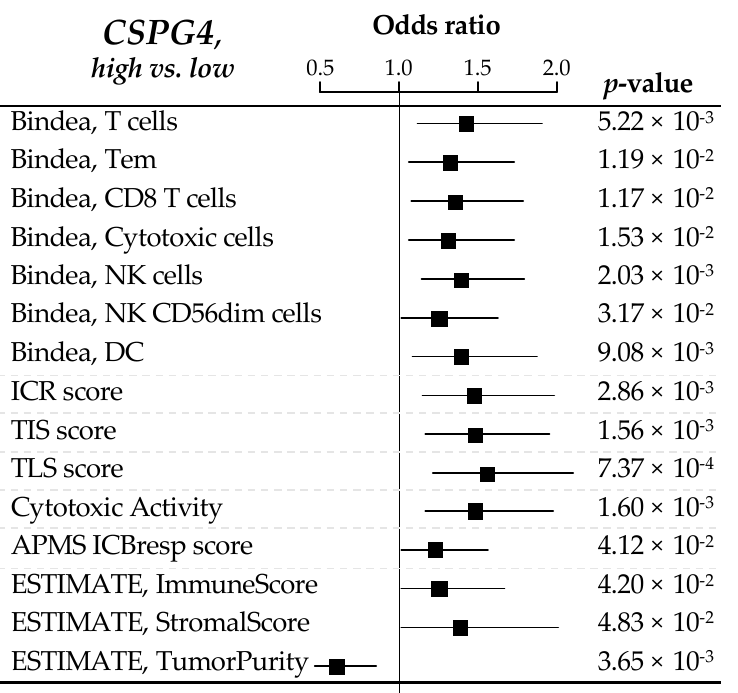
Figure 3. Correlations between CSPG4 expression and immune features. Forrest plot of correlations between CSPG4-high (left) and -low (right) expression and immune features, including the composition and functional orientation of the immune infiltrate according to the Bindea’s immunome, the Immunologic Constant of Rejection signature, T cell-inflamed signature (TIS) and tertiary lymphoid structures (TLS) enrichment signatures, the immune cytolytic activity score, the antigen processing/presentation machinery (APM) score, and ESTIMATE tool analysis for immune or stromal infiltrating cells. The p -values are for the logit link test.